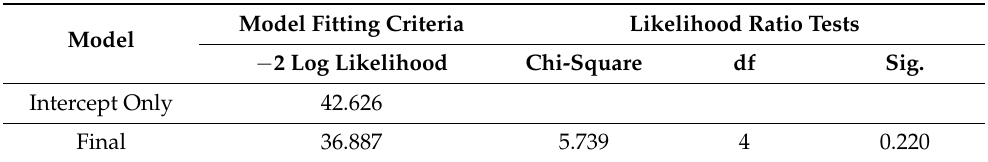
Table 9. Multinomial logistic regression analysis for the TNF-a - 308G/A genotypes. Model Fitting Information.